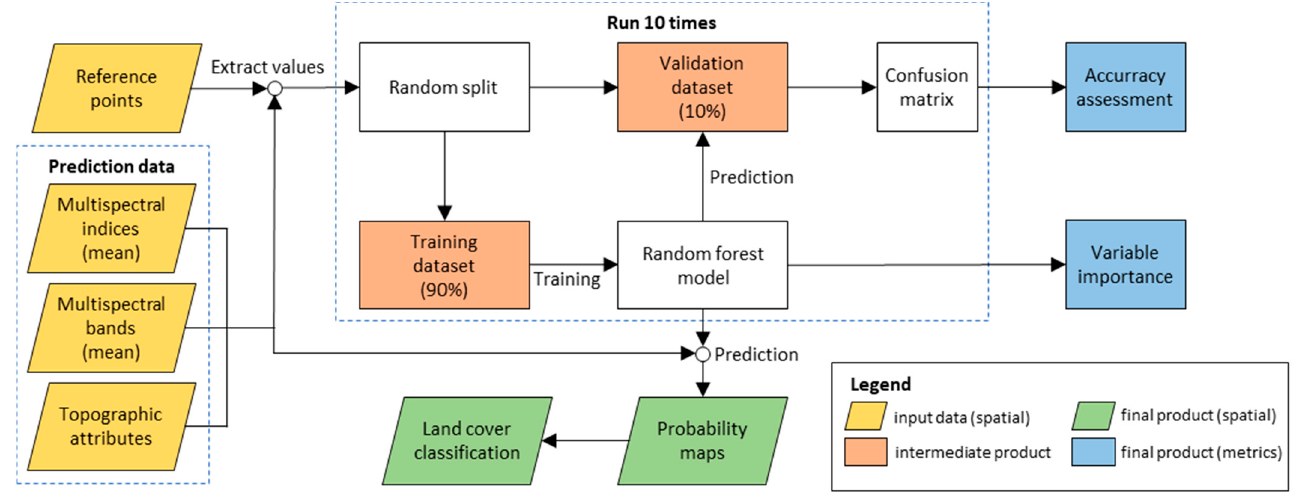
Figure 2. The workflow used for the Random Forest-based classification to spatiotemporally estimate and map the biological soil crusts.